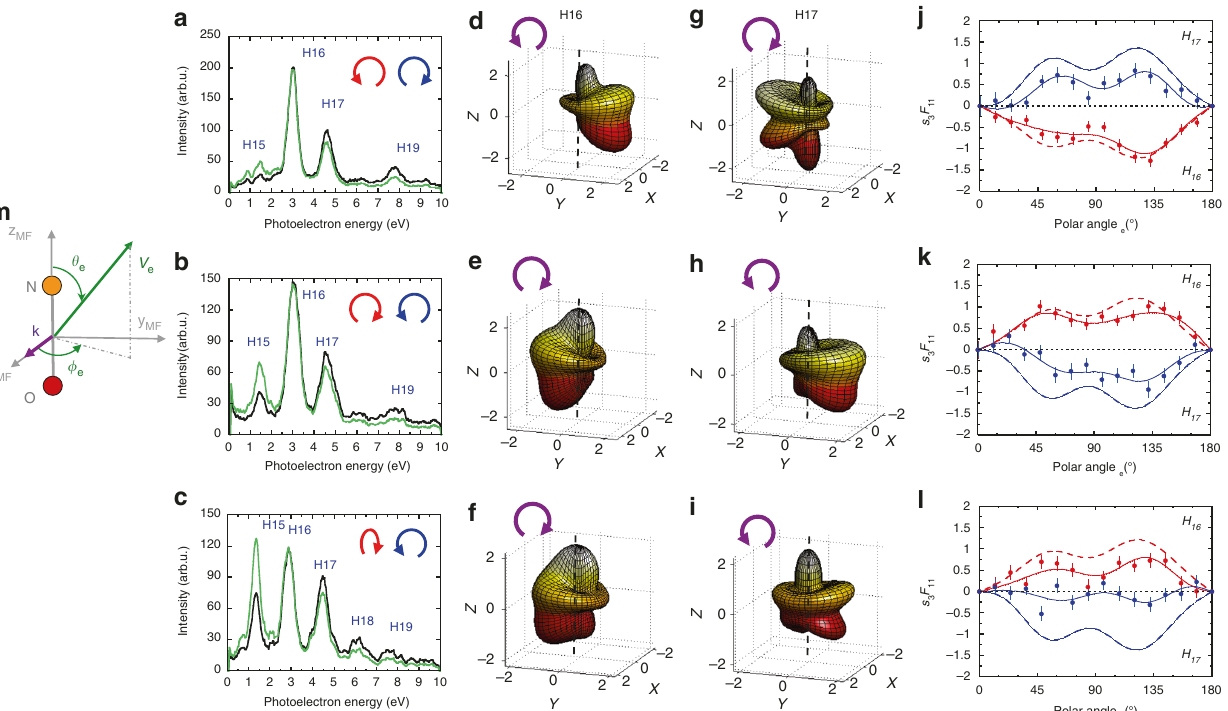
Fig. 5 Harmonic helicities characterized by molecular frame photoemission. The three rows correspond to the counter-rotating ω – 2 ω driving fi elds, as labeled in ( a , b , c ), fi rst row: LCP ( ε ω ≈ − 1) and RCP ( ε 2 ω ≈ + 1), second row: RCP ( ε ω ≈ + 1) and LCP ( ε 2 ω ≈ − 1), third row: right-elliptically polarized ( ε ω ≈ + 0.84) and LCP ( ε ≈ − 1). a – c Photoelectron spectra for reaction (1) induced by the harmonic beam, extracted from the electron-ion kinetic energy 2 ω correlation diagram as described in ref. 42 : raw data (black), corrected data accounting for the cross section of reaction (1) 73 (green). These spectra are discussed in Supplementary Note 7. d – f H16 and g – i H17 induced I χ = 90° ( θ e , ϕ e ) MFPADs for reaction (1) with NO oriented perpendicular to the k vector as shown in ( m ). j – l s 3 F 11 ( θ e ) (dots and Legendre polynomial line fi t) compared to the reference F R ð θ Þ is displayed with the + or − sign to facilitate comparison with s (red) and H17 (blue). F R e 11 isotropic Legendre component of the MFPAD (see Supplementary Note 1). The error bars correspond to twice the standard deviation resulting from a least squares fi t in χ , ϕ e , and γ of the experimental data by the model function (Supplementary Eq. (1))